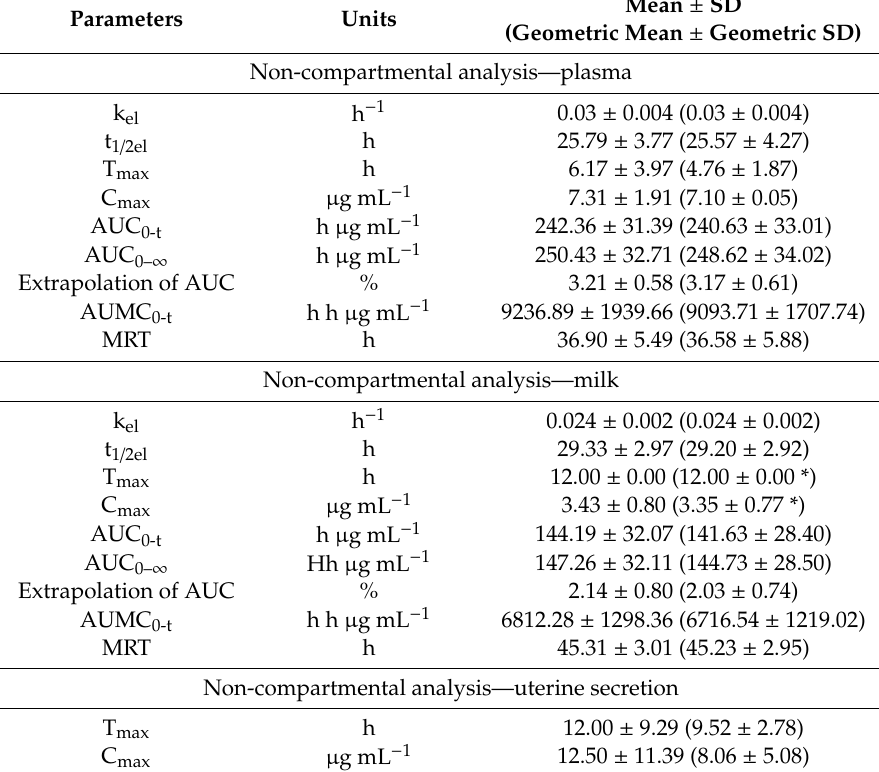
Table 1. Pharmacokinetic parameters in cows ( n = 6) with clinical metritis presented as arithmetic mean ± SD (Geometric mean ± geometric SD) after single intramuscular administration of 20 mg kg − 1 oxytetracycline hydrochloride as long-acting drug formulation.